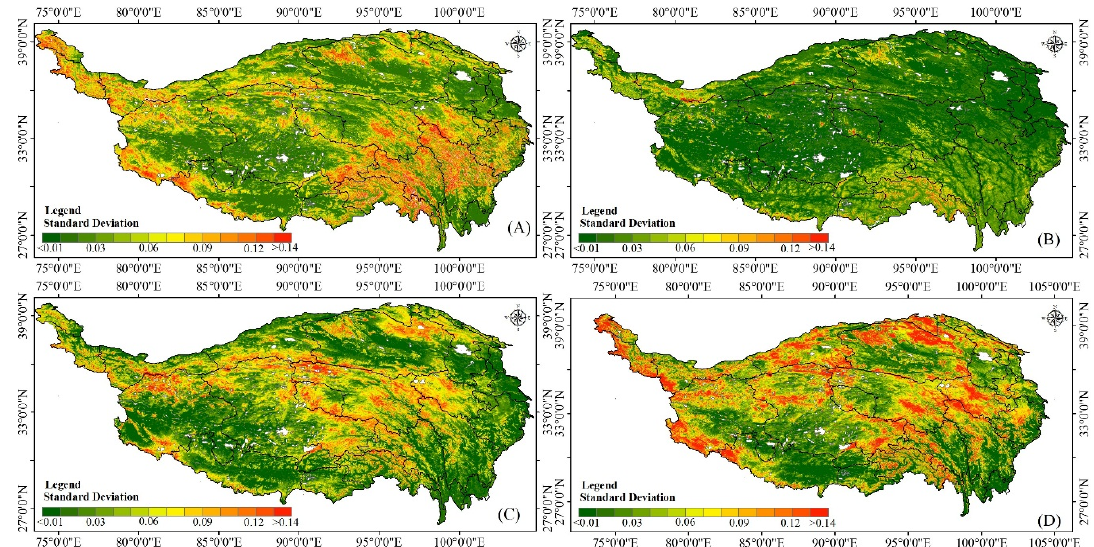
Figure 4. The albedo SD over the entire TP for the four seasons ( A ). Spring season; ( B ). Summer season; ( C ). Autumn season; ( D ). Winter season.